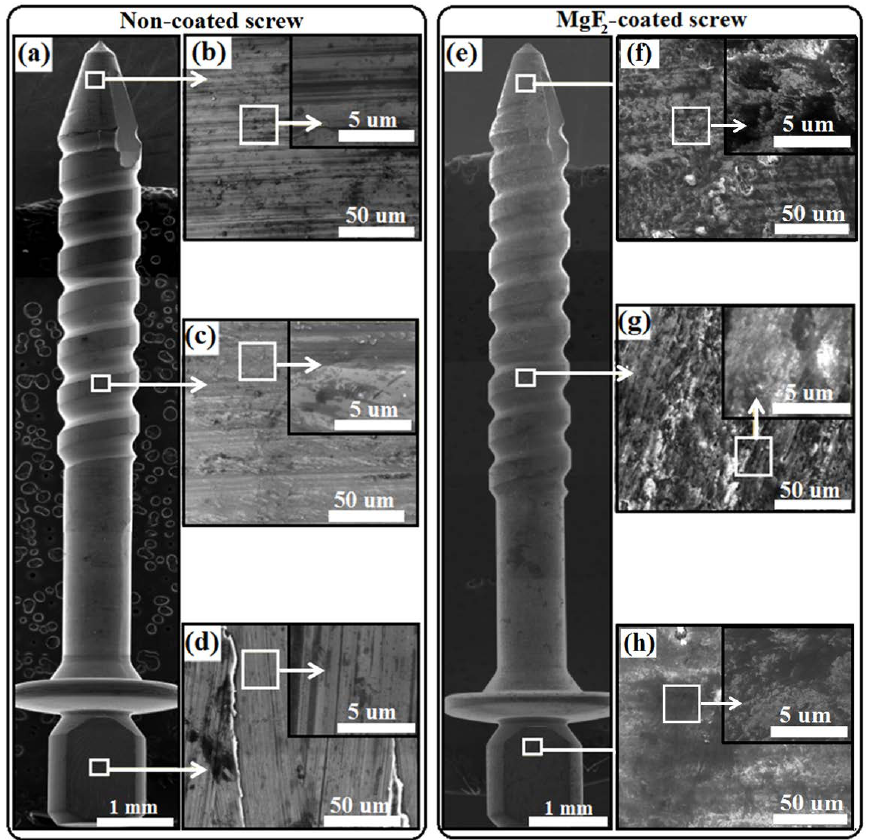
Figure 2. SEM analysis of non-coated ( a ) and MgF 2 -coated screws ( e ); high magnification micrographs of the tip ( b , f ), thread ( c , g ), and head ( d , h